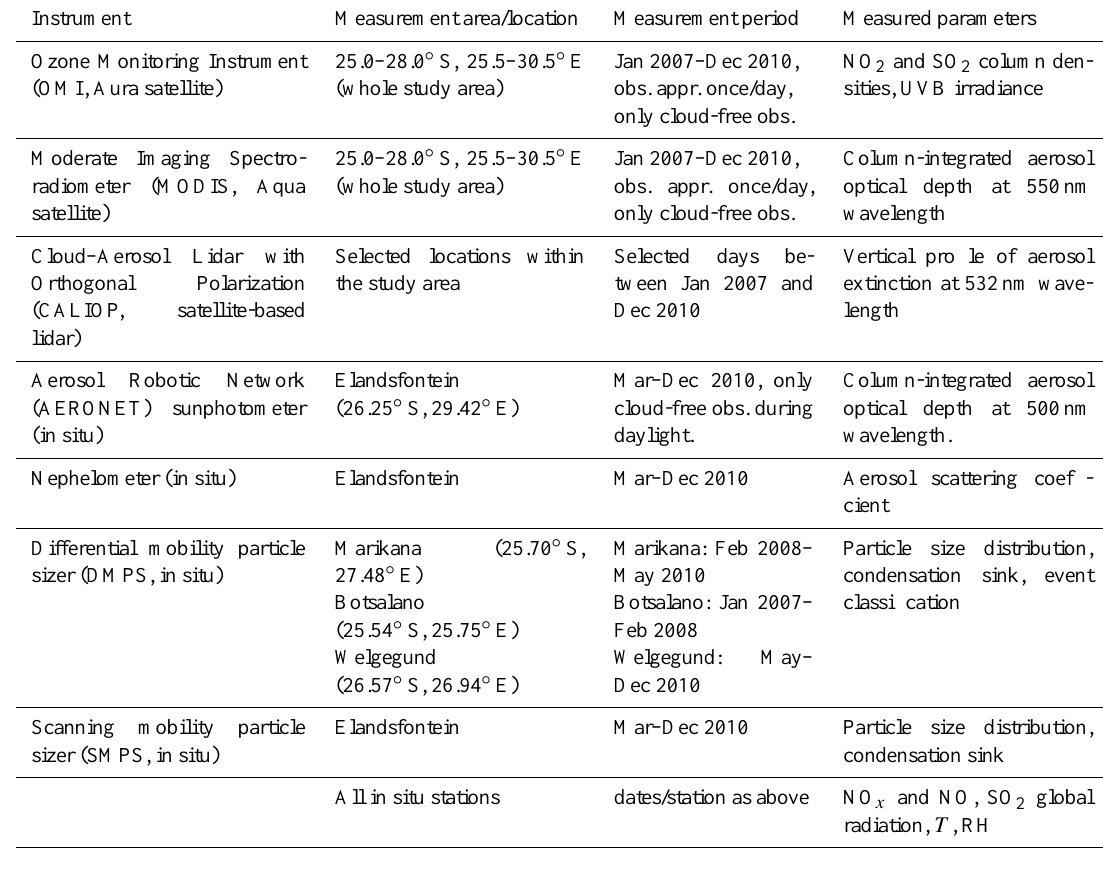
Table 1. A summary of the measurements used in this study. Listed are only those measurements from the study period 1 January 2007– 31 December 2010.